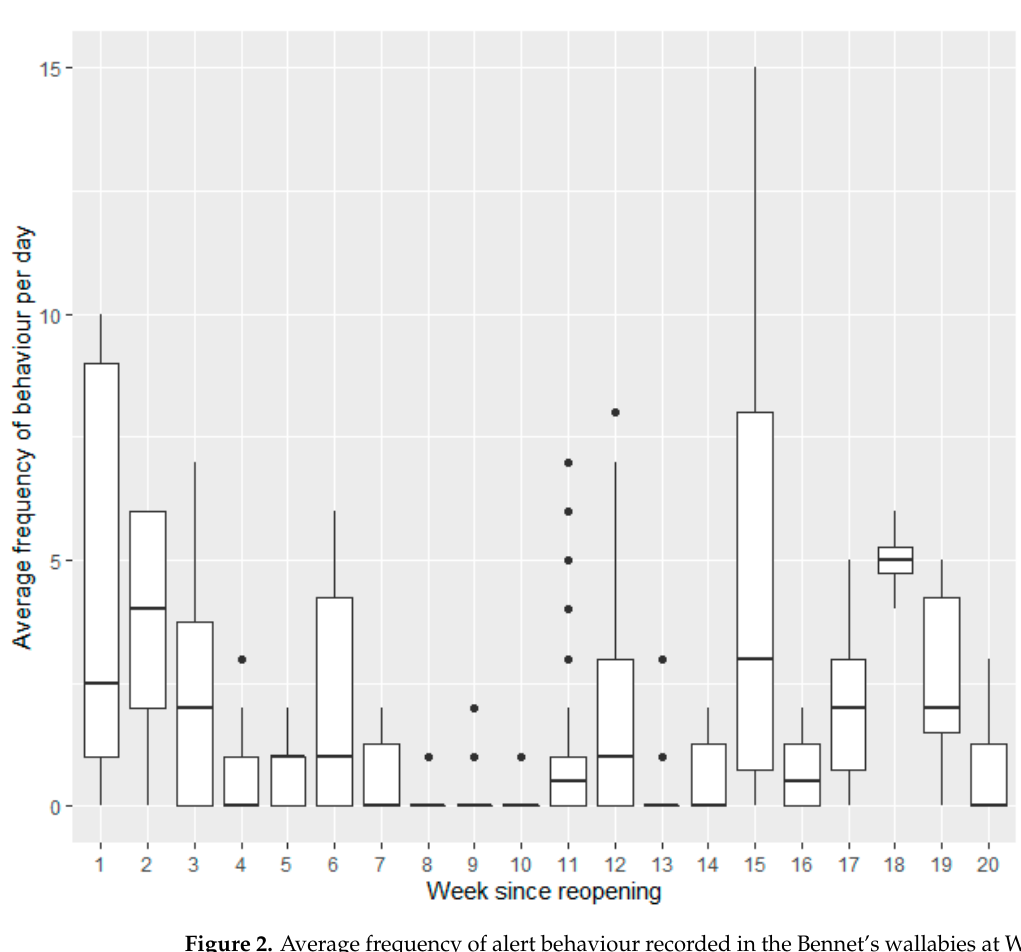
Figure 2. Average frequency of alert behaviour recorded in the Bennet’s wallabies at White Post Farm per day in the weeks since the facility reopened to the public. Dots represent outliers.